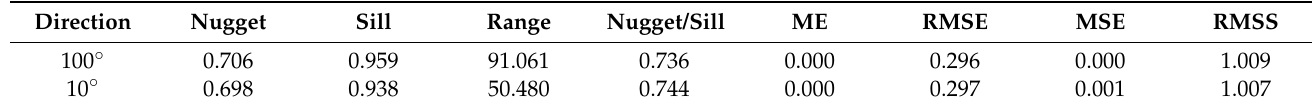
Table 5. Results of semivariogram analysis.